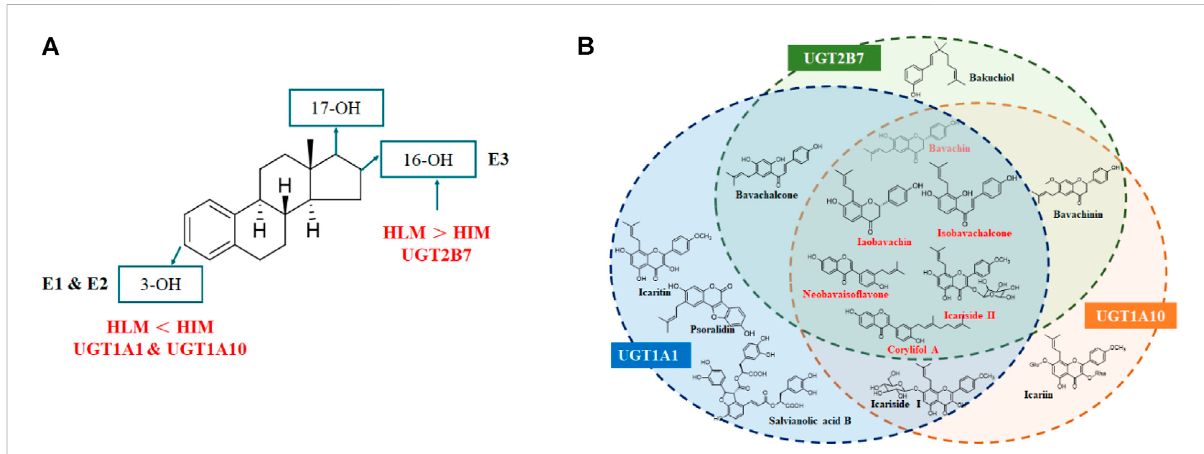
FIGURE 8 Metabolic characteristics of estrogens by HLM, HIM, and major UGT enzymes (A) and identi fi cation of natural inhibitors in XLGB against the glucuronidation of estrogens (B)